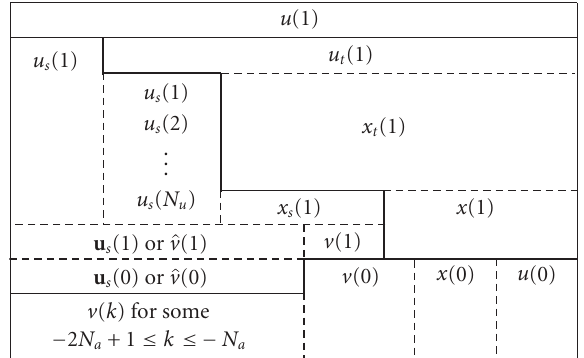
Figure 1: Derivations of unknown variables from known